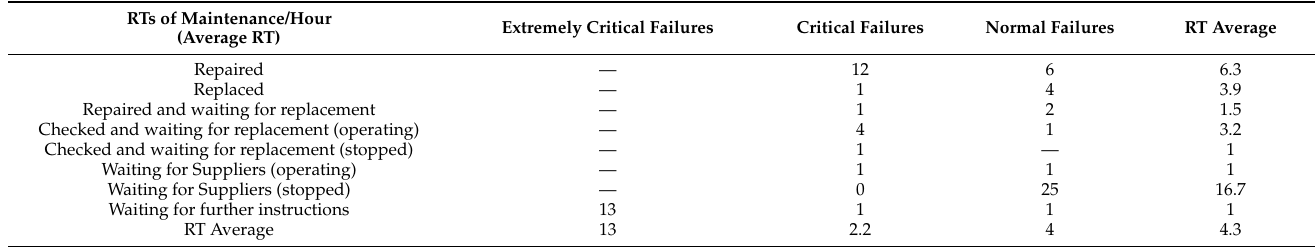
Table 9. RTs of maintenance sorted by failure criticality and maintenance measures/hours.